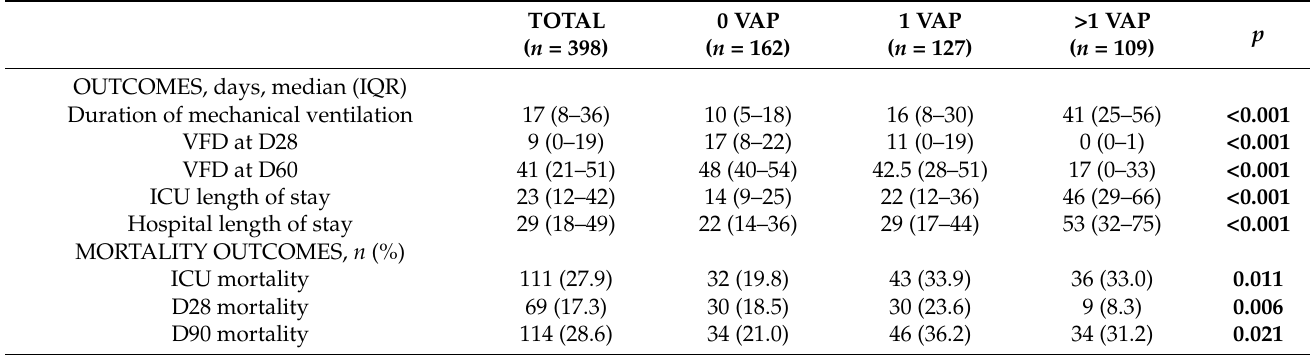
Table 4. Clinical outcomes according to the occurrence of VAP and